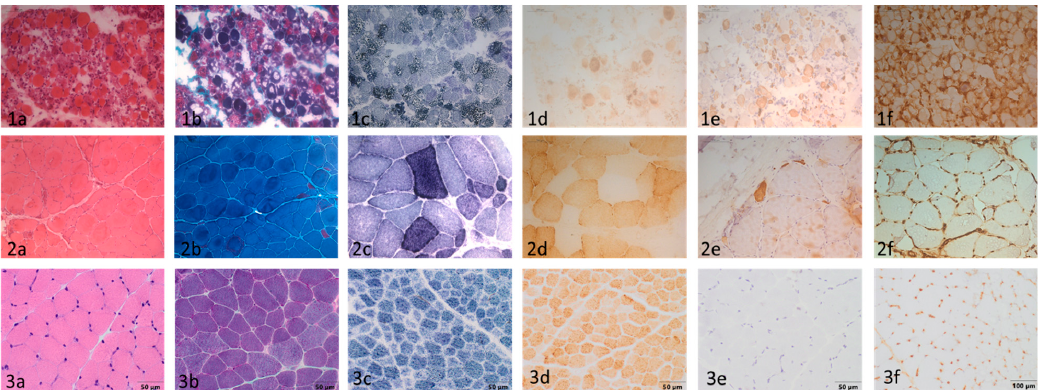
Figure 1. Muscular biopsy from patients with infantile-onset (row 1, corresponding to case 1), child- hood-onset (row 2, corresponding to case 8), and a healthy control (row 3). Columns: ( a ) haematox- childhood-onset (row 2, corresponding to case 8), and a healthy control (row 3). ylin-eosin stain; ( b ) Gomori’s modified trichrome stain; ( c ) SDH stain; ( d ) COX stain; ( e ) immuno-